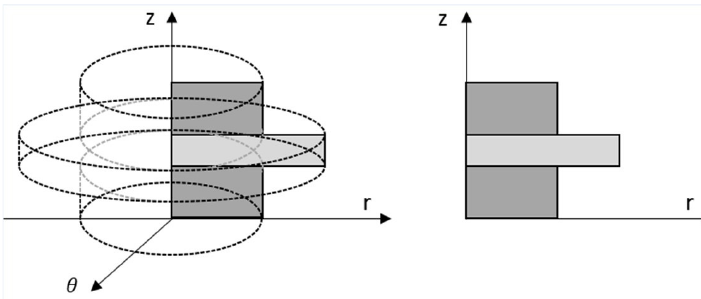
Figure 2. Domain and contour simplification in axisymmetric